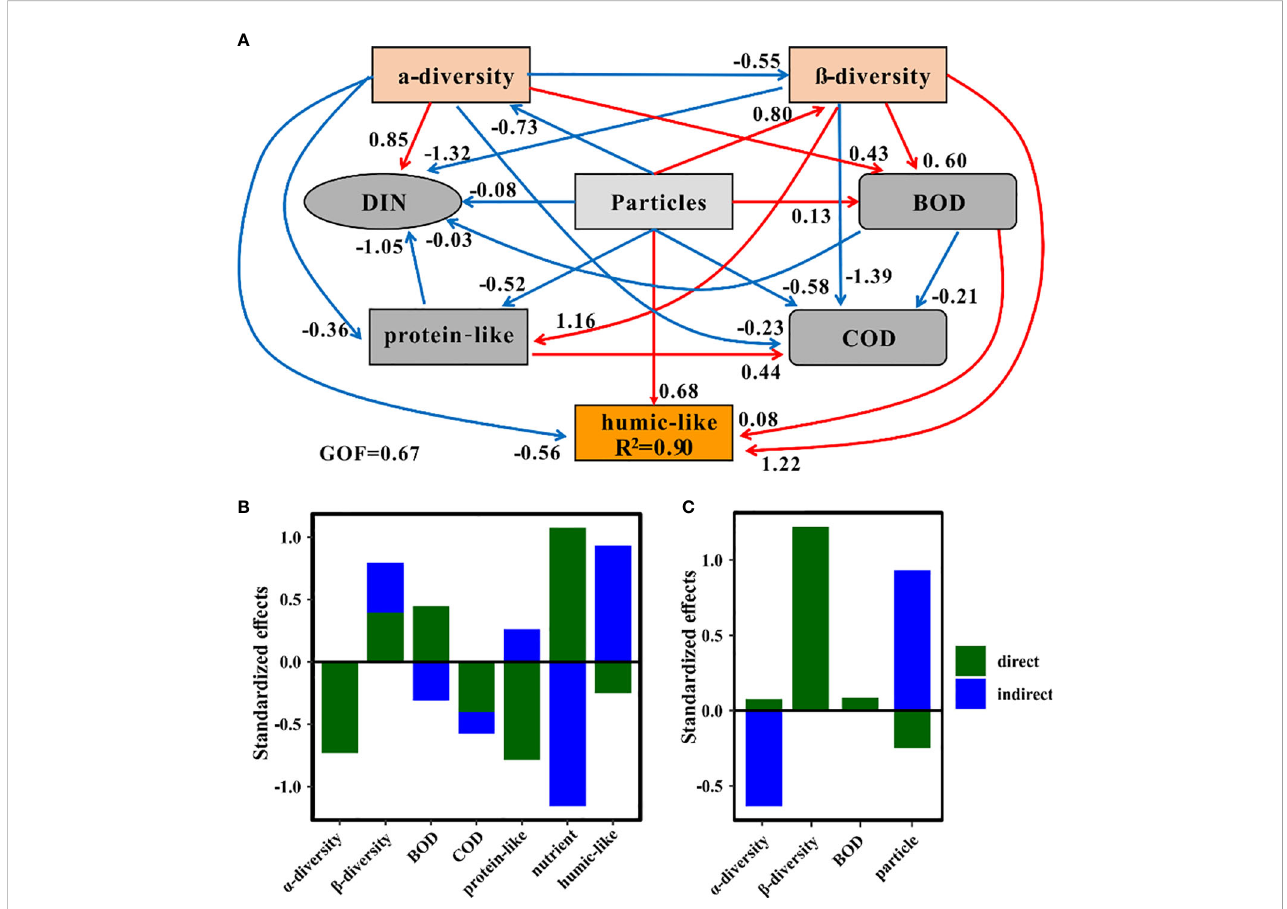
FIGURE 6 Partial least squares path models showing the effects of terrigenous particles on other variables. (A) Effects among different factors monitored in this system based on partial least squares path analysis. GOF, goodness of fi t. The blue arrows represent the negative effect, while the red arrows indicate the positive effect. (B) Standardized effects of particles on other factors. (C) Standardized effects of factors on the humic-like